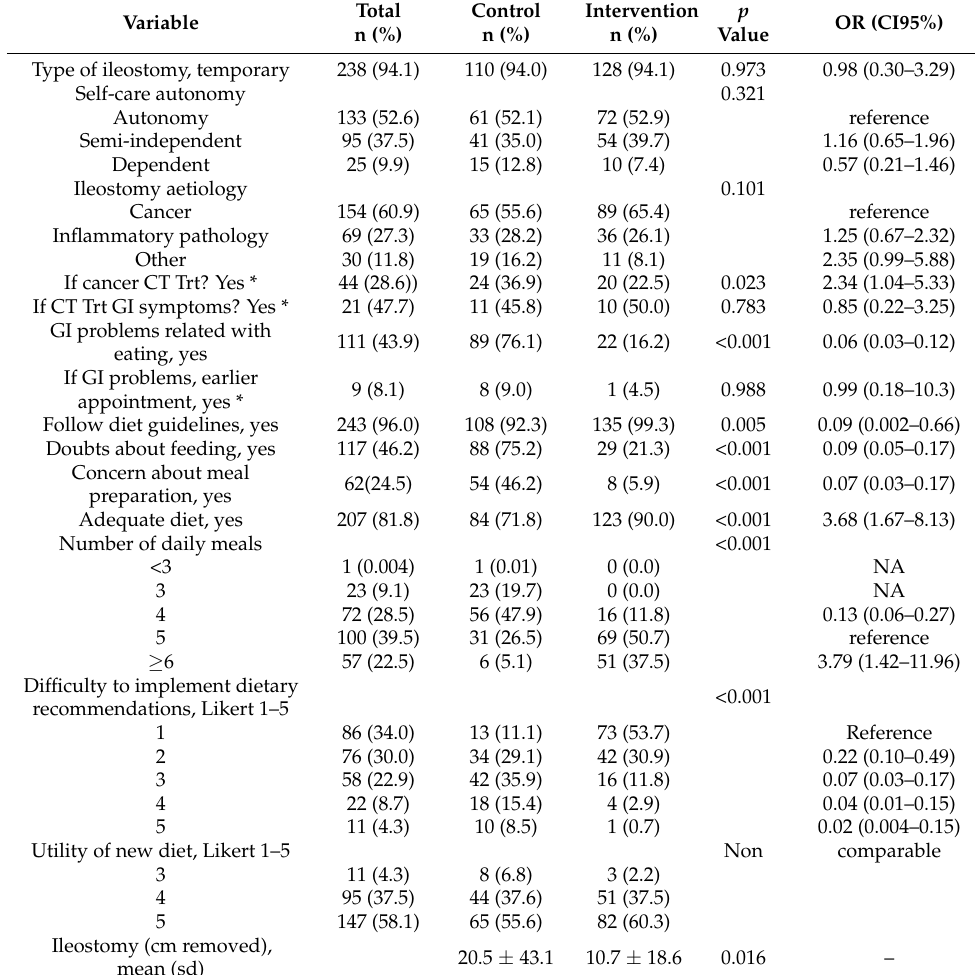
Table 2. Clinic, anthropometric and satisfaction